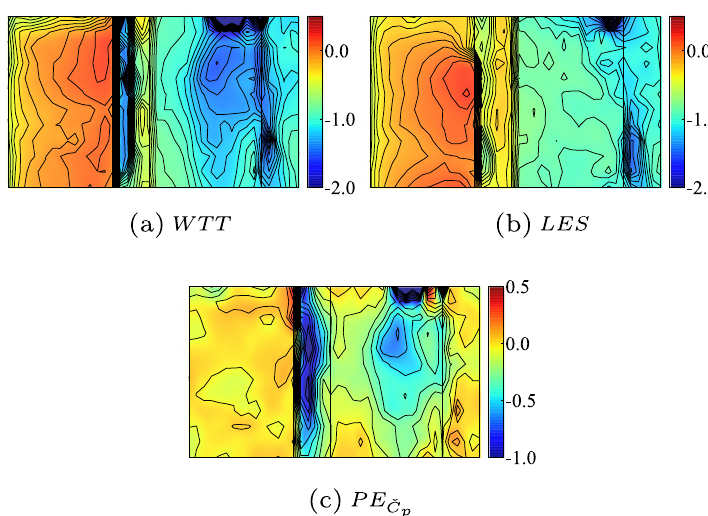
Fig. 12 The surface distributions of the ˇ C p and the PE ˇ